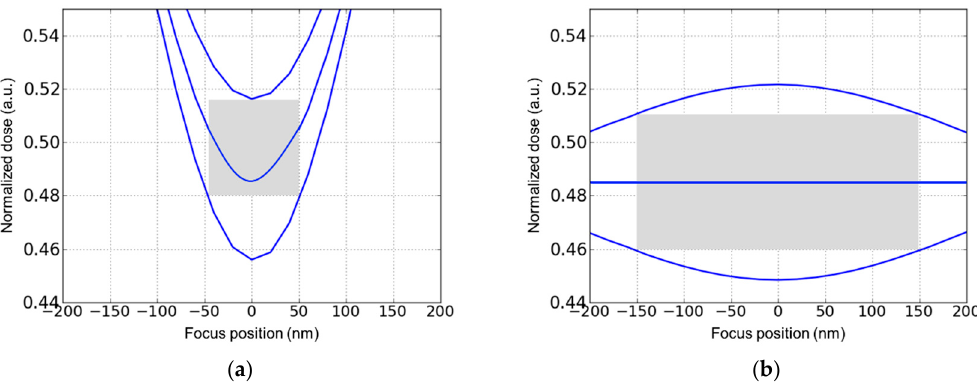
Figure 3. Aerial image-based process window on a 193 nm dry lithography system with adapted illumination as in Figure 2, for ( a ) 65 nm lines/130 nm spaces (duty factor 1:2). ( b ) 65 nm dense lines: 65nm lines and spaces with a duty factor of 1:1.